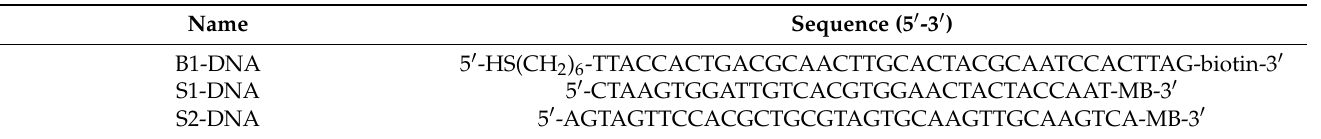
Table 1. Sequences of the oligonucleotides used in this